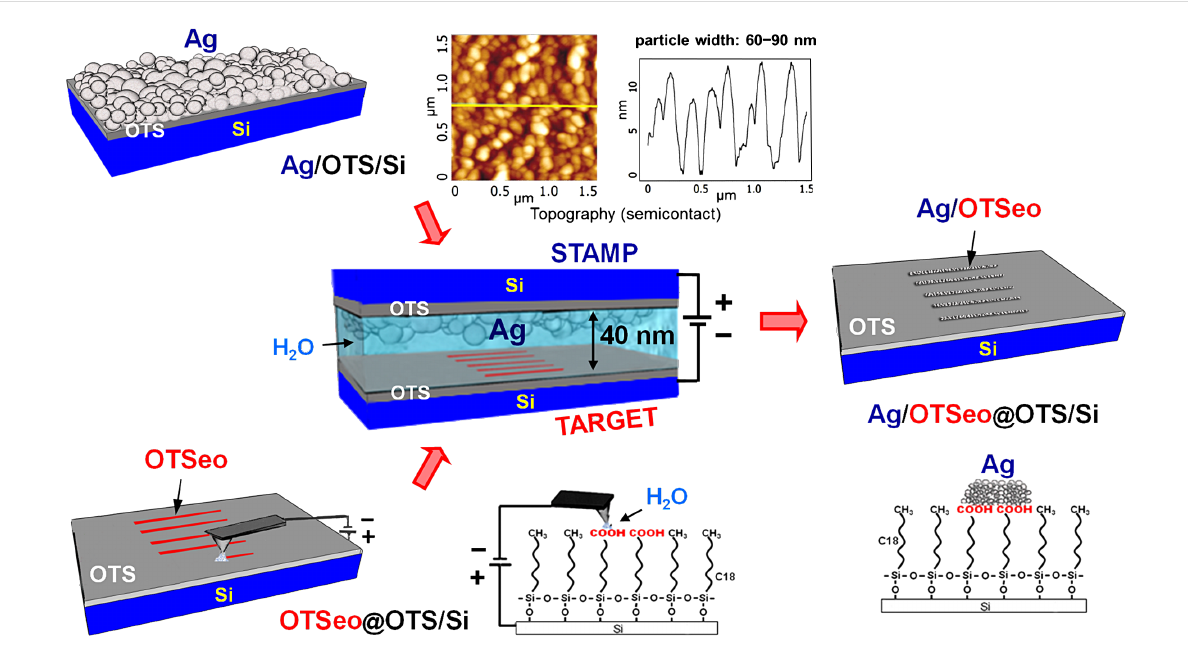
Figure 1: Scheme of parallel-contact electrochemical metallization of a OTSeo@OTS/Si template nanopattern (target, cathode) consisting of an array of parallel OTSeo lines serially inscribed with a conducting SFM tip on a self-assembled OTS monolayer on silicon (CNL process, bottom left). Selec- tive silver deposition on the OTSeo lines of the patterned monolayer (right) is achieved by contact electrochemical transfer of the metal (center) from a stamp (anode) consisting of a thin (~40 nm), granular Ag film deposited by metal evaporation on the entire surface (2–4 cm 2 ) of an OTS/Si monolayer specimen (top) [30]. The granular morphology of such silver-film stamps is evident in the displayed SFM image. During the application of the bias voltage (center), the stamp–target sandwich is equilibrated with a water-saturated atmosphere (see Experimental